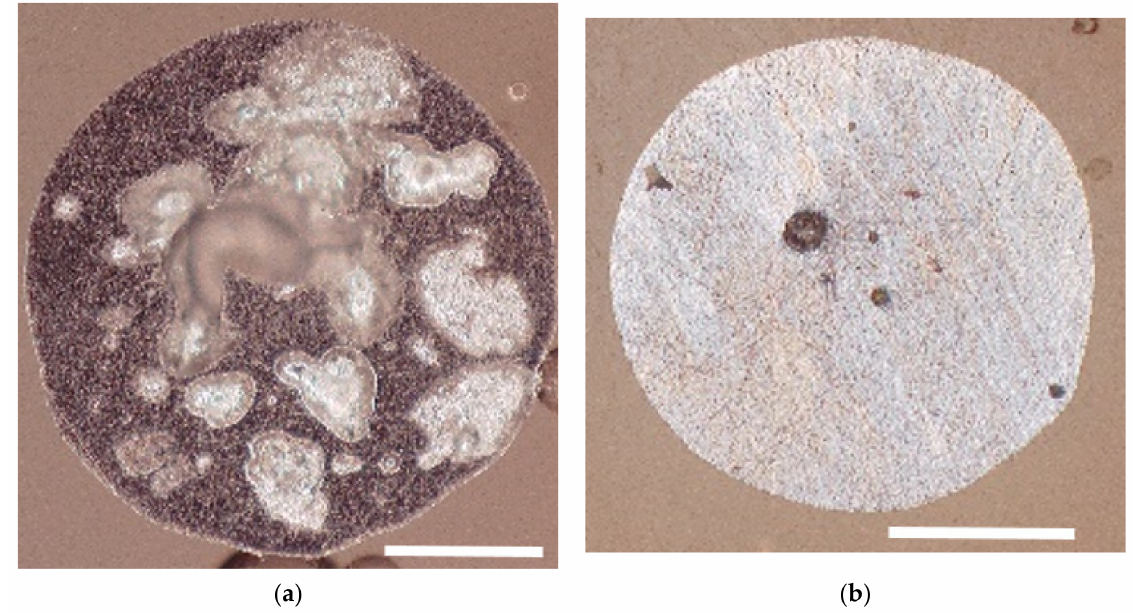
Figure 11. Bottom view of the deposited droplet printed at substrate temperature of ( a ) 25 ◦ C and ( b ) 150 ◦ C. Scale bar = 250 µ